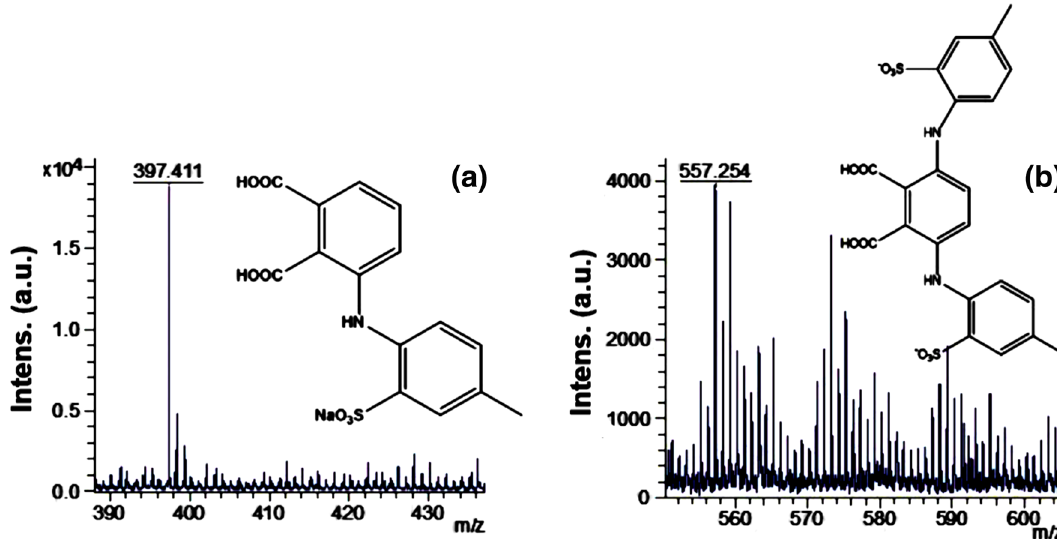
Figure 13. Mass spectra and the assignment of peaks observed in aqueous solution after discoloration/ degradation of AG-25 by H 2 O 2 in the presence of 3D-rGO.